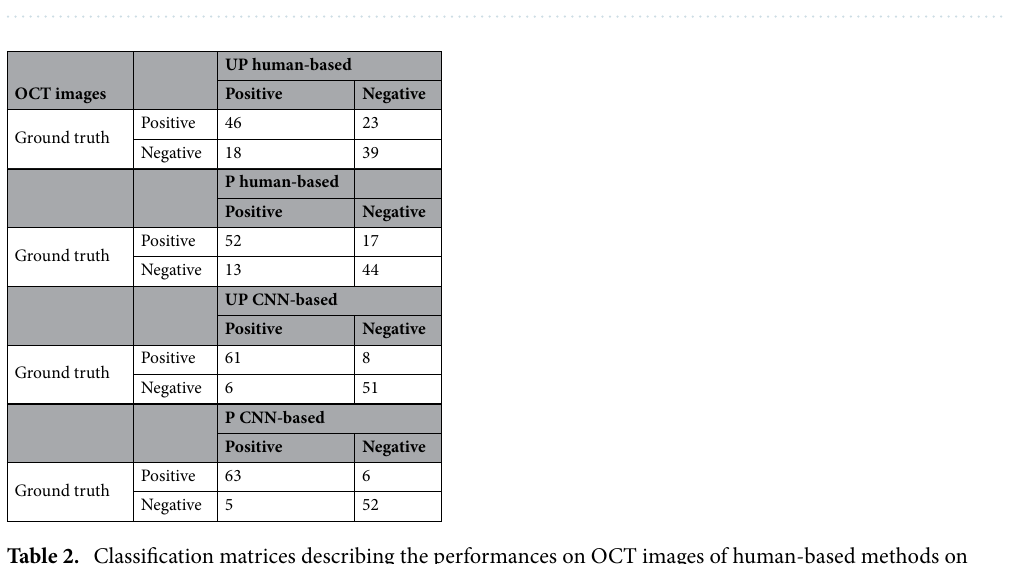
Figure 2. ROC curves illustrating accuracy of the 4 classification methods on BAF images. BAF blue autofluorescence, CNN convolutional neural network, P-BAF processed BAF images, UP-BAF unprocessed BAF images.